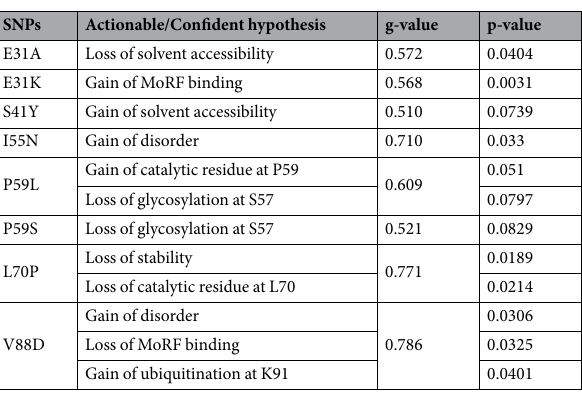
Table 6. Prediction of disease related amino acid substitution and phenotypes by